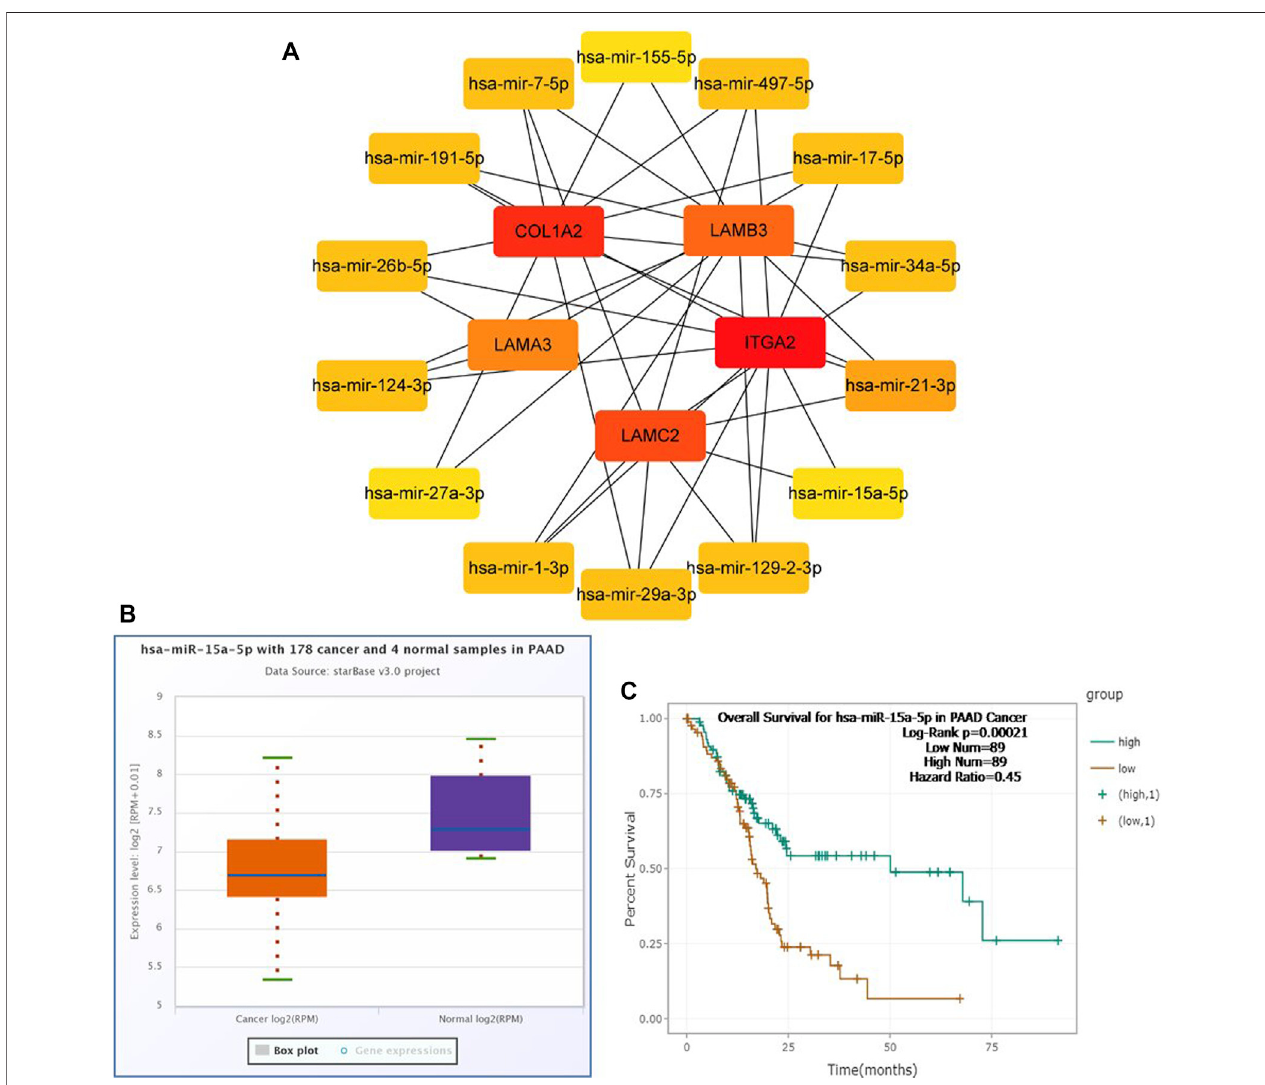
FIGURE8| Identi fi cation ofhsa-miR-15a-5p asapotential miRNAinPAAD. Cytoscape softwarewasused toscreenthemiRNAsthatwerecloselyrelated tohub- mRNAs. Through the differential expression and survival analysis ofthe starbase database, one miRNA was selected. (A) miRNA – mRNA regulatory networkwasset up byCytoscapesoftware. (B) Expressionofhsa-miR-15a-5pinPAADandnormalsampleswasexaminedbythestarBasedatabase. (C) Prognosticvalueofhsa-miR-15a- 5p in PAAD was evaluated by the Kaplan – Meier plotter.